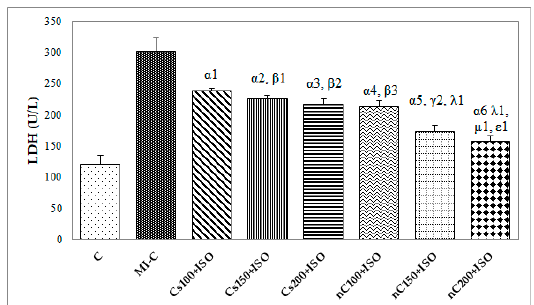
Figure 4. Serum levels of lactate dehydrogenase (LDH) by groups. C = control; MI-C = isoproterenol without any pre-treatment; Cs = curcumin solution, in doses of 100 mg / kg bw (Cs100), 150 mg / kg bw (Cs150), and 200 mg / kg bw (Cs200); nC = curcumin nanoparticle solution, in doses of 100 mg / kg bw (nC100), 150 mg / kg bw (nC150), and 200 mg / kg bw (nC200). The letter-number codes correspond to the p -values < 0.05: α as compared with MI-C, β as compared with CS100 + ISO, γ as compared with CS150 + ISO, λ as compared with nC100 + ISO, µ as compared with nC150 + ISO, ε as compared with Cs200 + ISO.